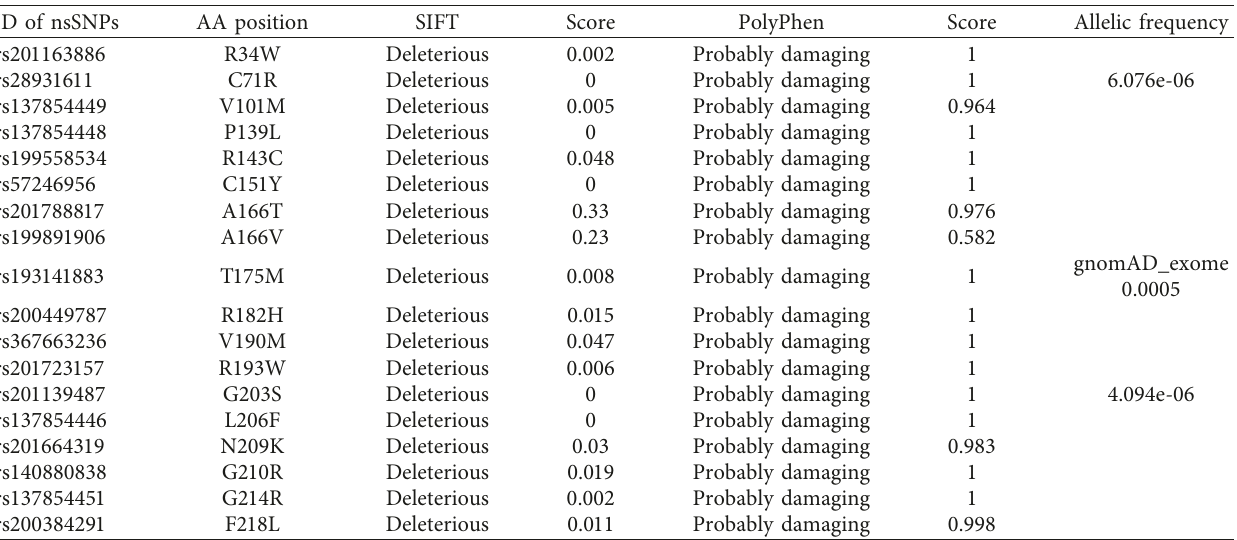
Table 1: SIFT and PolyPhen deleterious